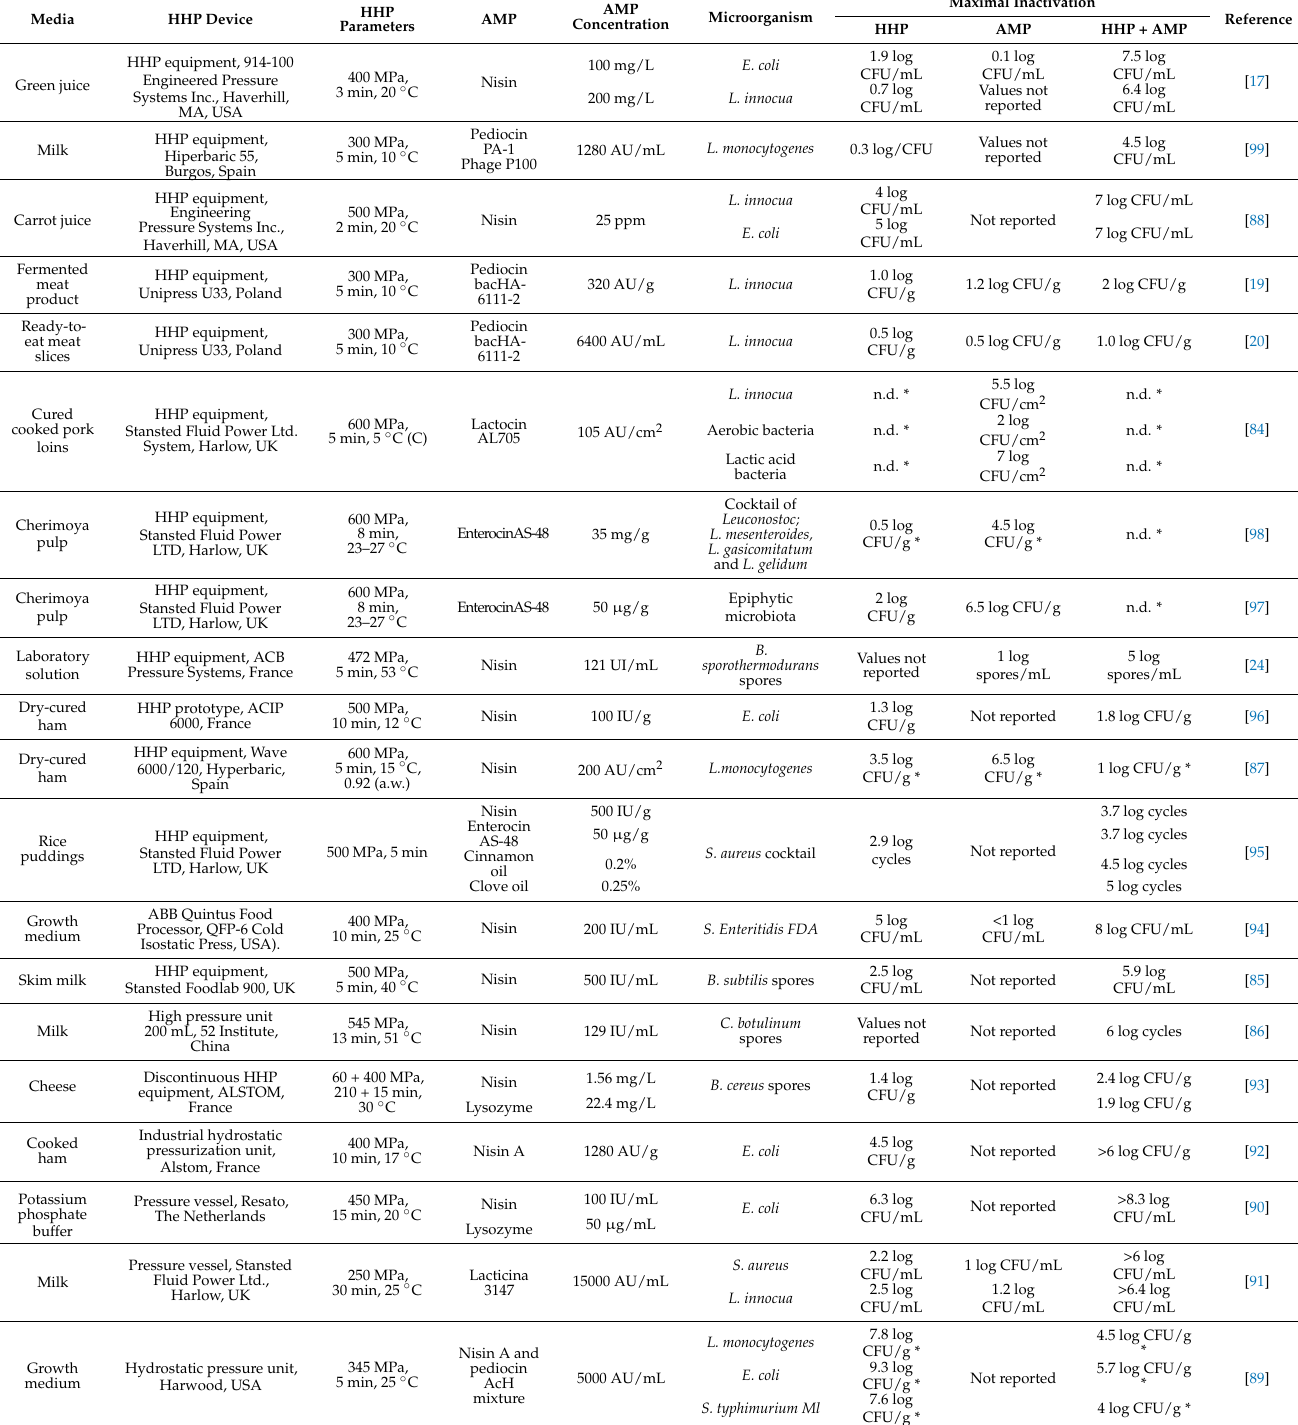
Table 6. Effect of high hydrostatic pressure (HHP) and antimicrobial peptides (AMP) on microbial inactivation in food